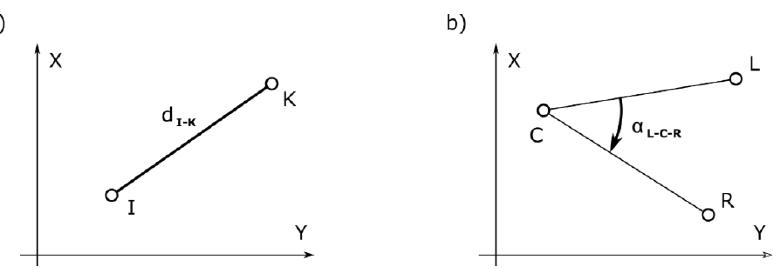
Figure 4. The geometry related to the conditional equations of the distance ( a ) and angle ( b ) in the horizontal plane.